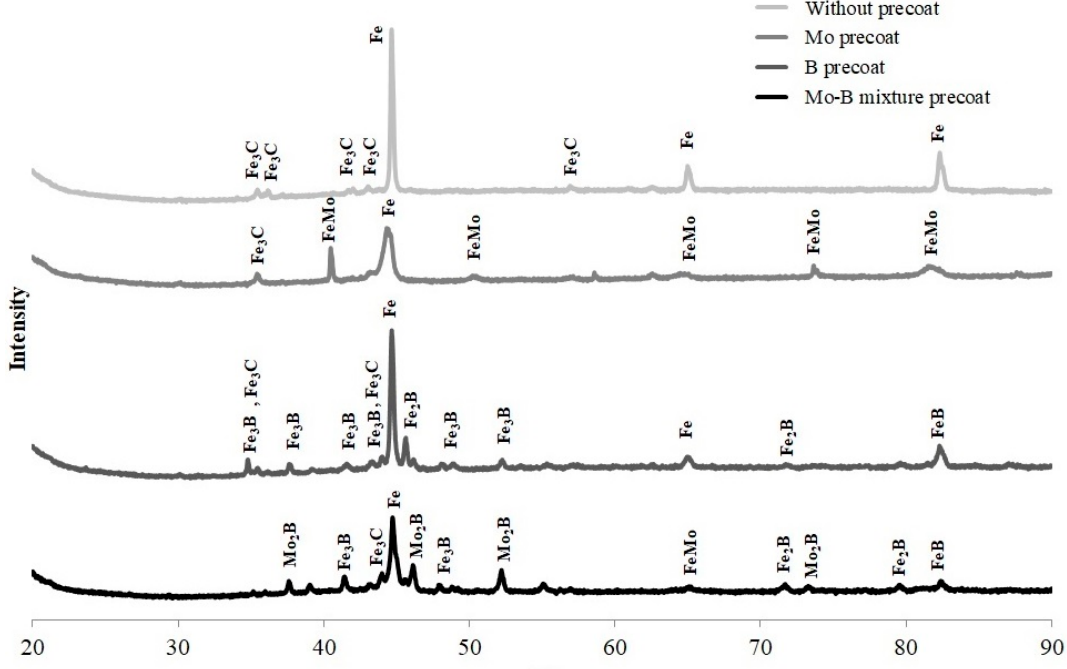
Figure 6. X-ray di ff raction spectrum after laser alloying of studied Figure 6. X-ray diffraction spectrum after laser alloying of studied materials.